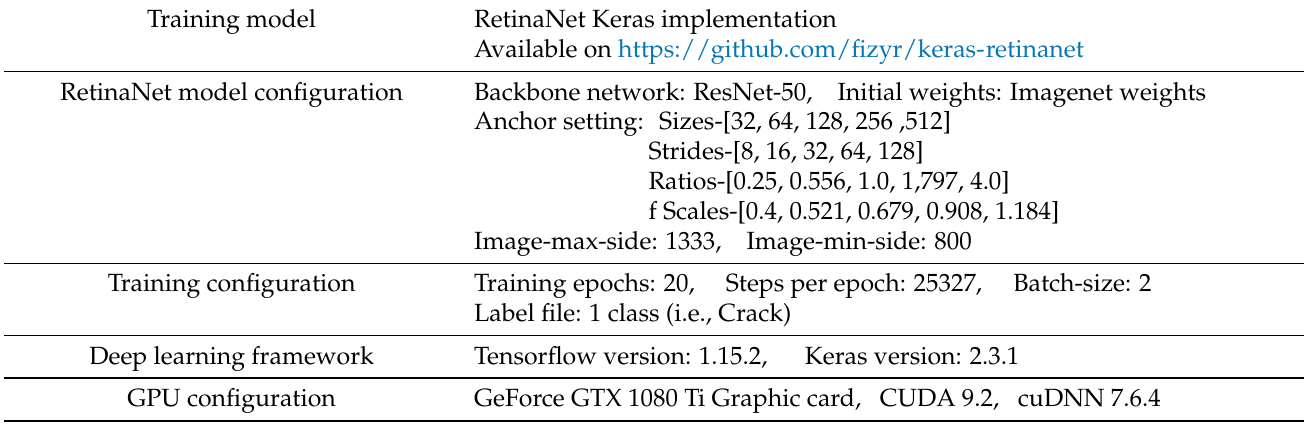
Table 3. Object detection model training environment and